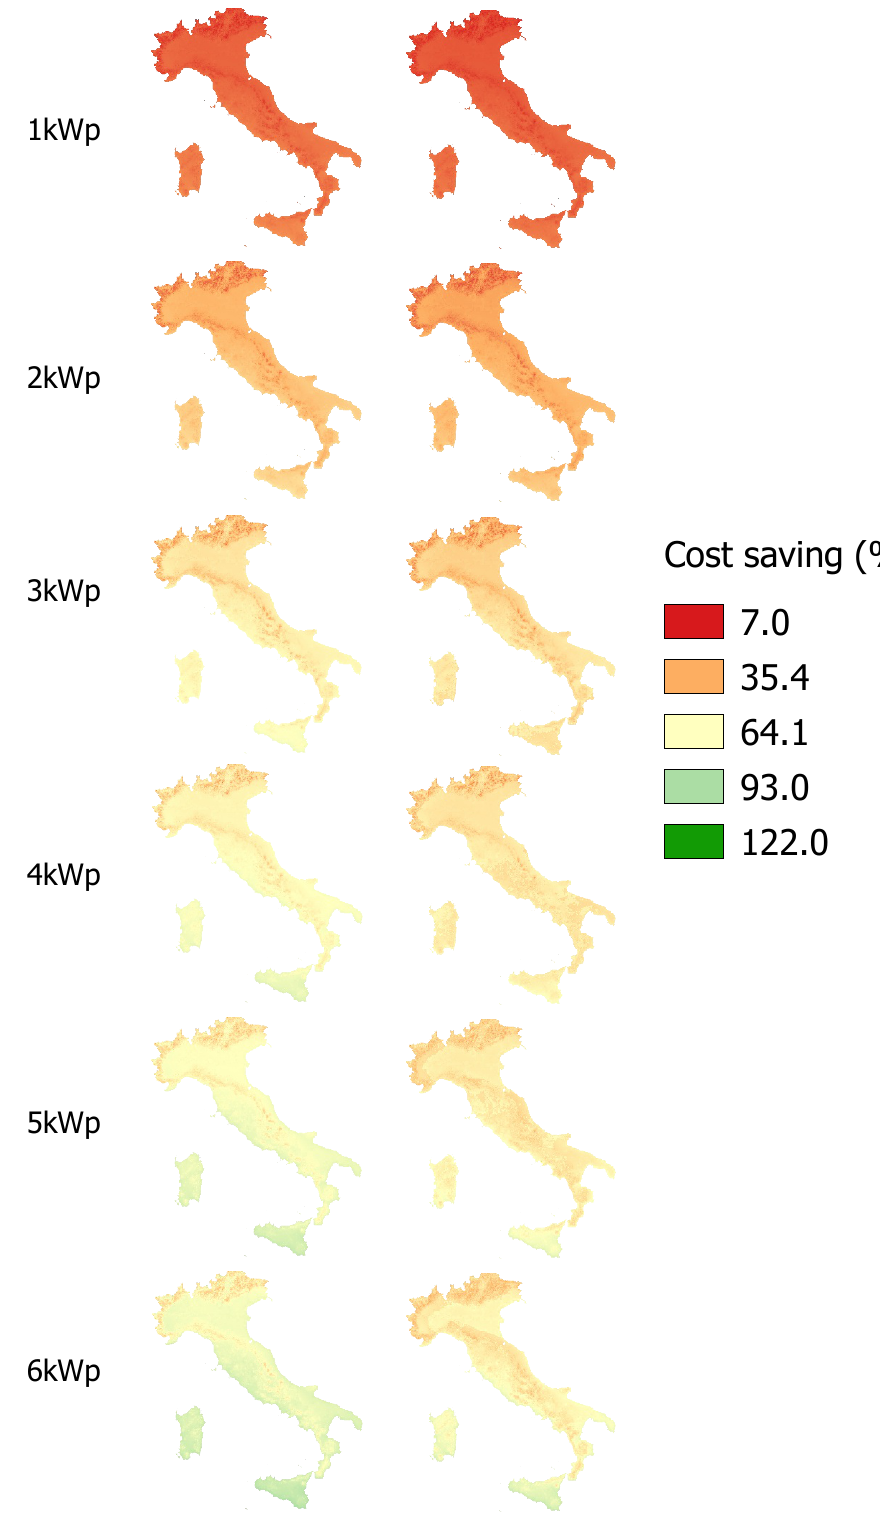
Figure A11. Cost saving for E L = 4000 kWh, left side without battery and right side with